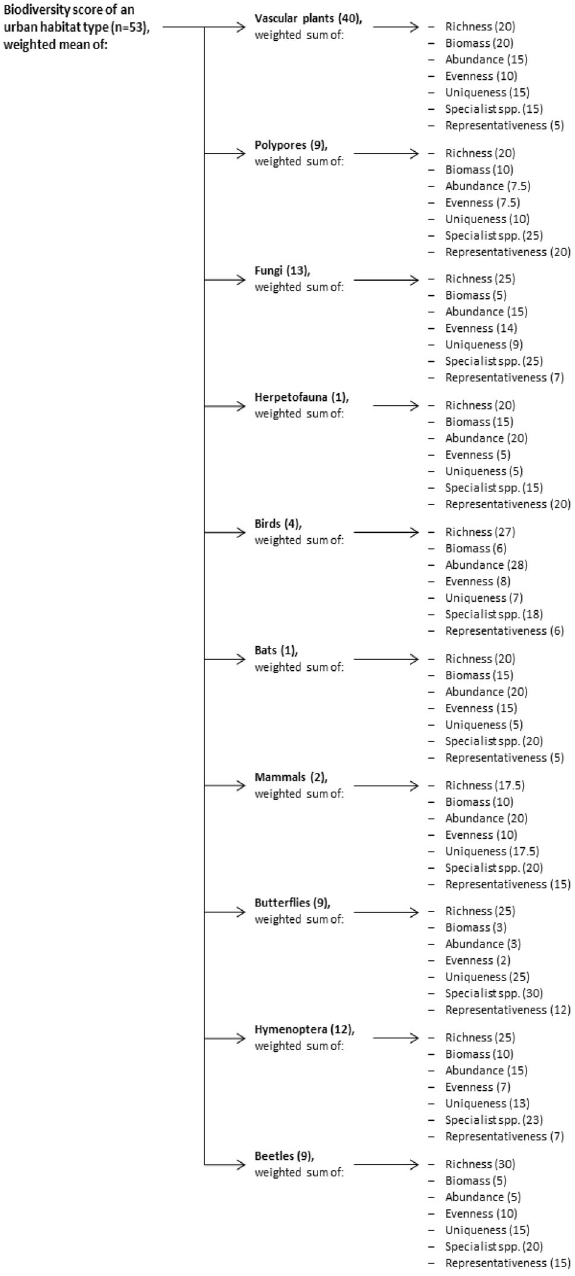
Fig. 5 Scores assigned to components of biodiversity. Scores for different urban habitat types were calculated as weighted mean of scores for different taxa, that themselves were calculated as weighted sums of expert-given scores regarding Biodiversity Quality attributes. Weights are shown in parentheses. Both the inter-taxa weights, and the attribute weights within each taxon score add to